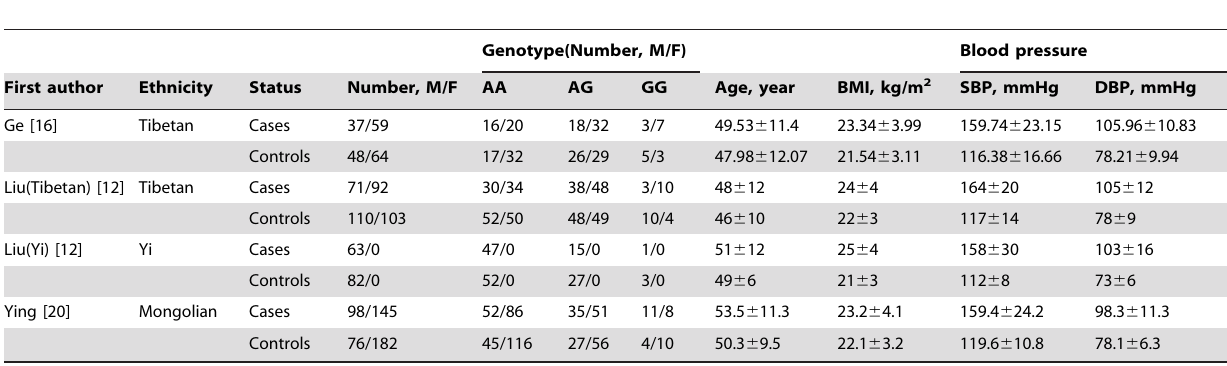
Genotype(Number,